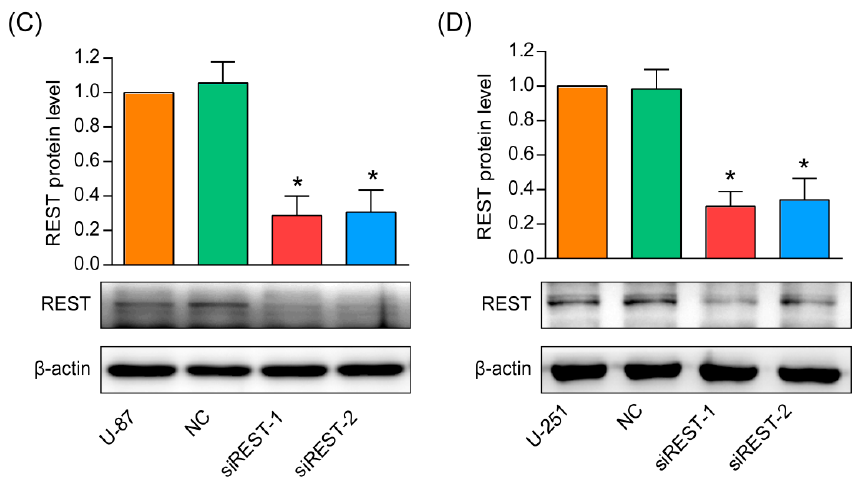
Figure 1. siRNA-mediated down-regulation of repressor element 1-silencing transcription factor (REST) in glioblastoma (GBM) cells. After U-87 and U-251 cells were transfected with siREST-1, siREST-2 or NC (scramble siRNA as negative control) for 48 h, the mRNA and protein levels of REST were determined by real-time PCR and Western blotting, respectively. ( A ) mRNA levels of REST in transfected U-87 cells; ( B ) mRNA levels of REST in transfected U-251 cells; ( C ) protein levels of REST in transfected U-87 cells; ( D ) protein levels of REST in transfected U-251 cells. * p < 0.05 compared with NC group.